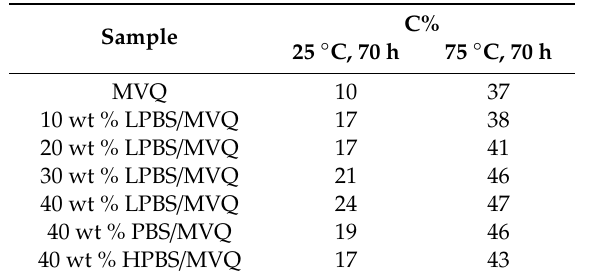
Compressive permanent deformation rate of composite silicone rubber at di ff erent temperatures.